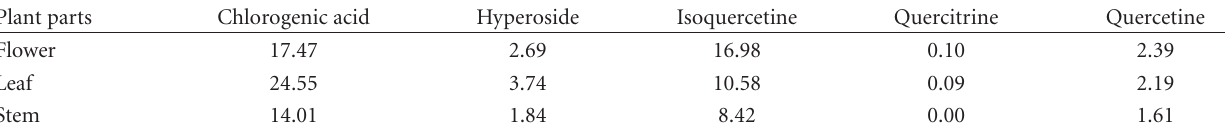
Table 1: Secondary metabolites content (mg/g DW) in stem, leaf, and flower of Hypericum leptophyllum .